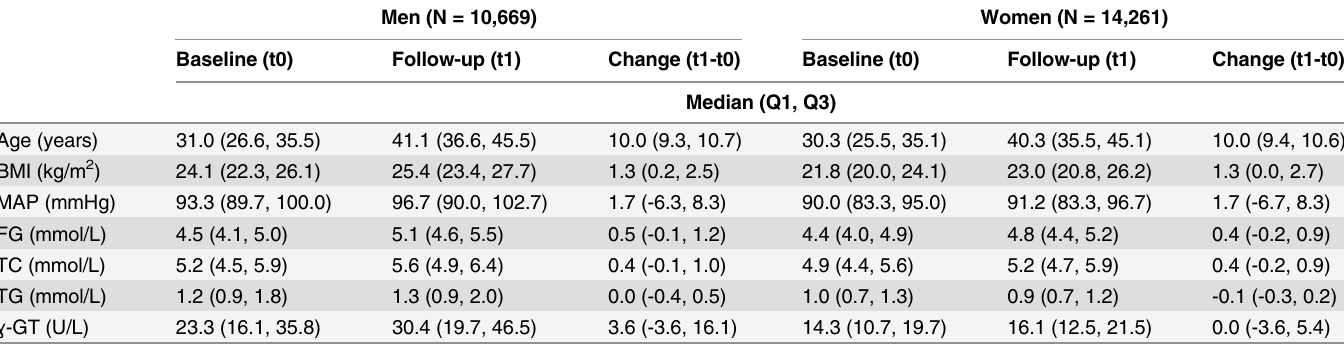
Table 1. Characteristics of the study population at baseline and 10-year follow-up.